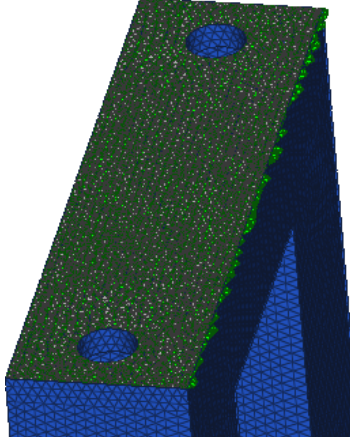
Figure 5. Face to face contact pairs of upper crossbeam and col- umn.